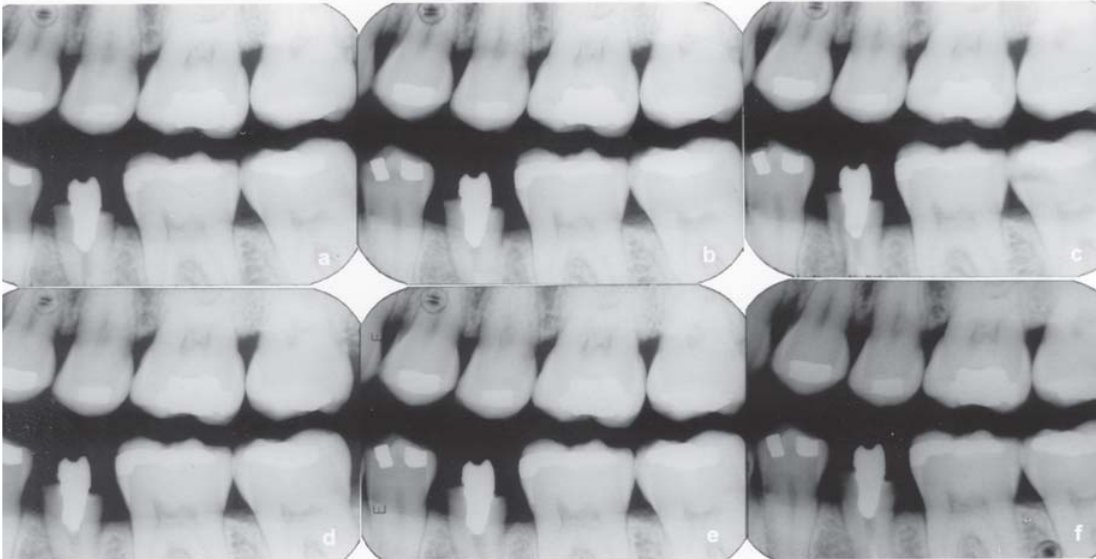
FIGURE 2- Bitewing radiographs of second mandibular premolar before (a) and after crown lengthening procedures (b), at 2- (c), at 3- (d), at 6- (e) and at 12-month periods (f). The presence of intact lamina dura is observed at mesial and distal alveolar crests, respectively, at 6- and 12-month